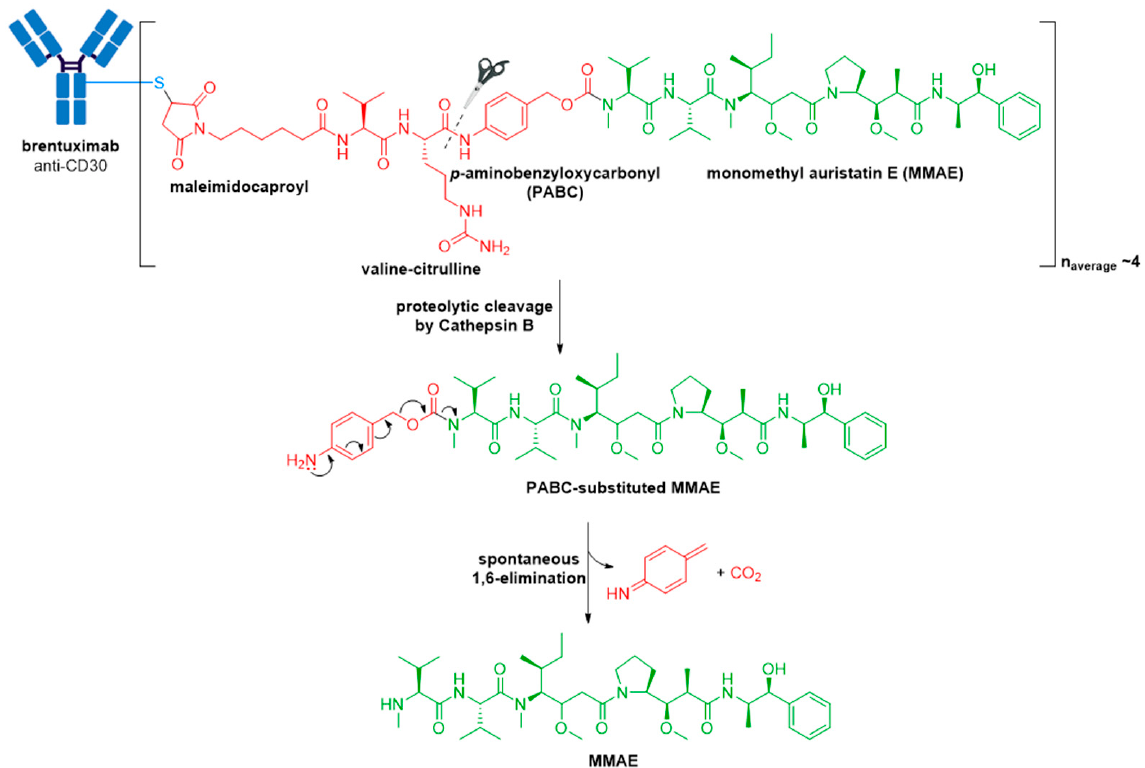
Figure 6. Structure of Adcetris ® (brentuximab vedotin). The antibody is shown in blue, and chemical structures for linker and payload are in red and green, respectively. Spontaneous 1,6-elimination mechanism for the PABC-substituted MMAE, leading to release of MMAE, p -iminoquinone methide, and carbon dioxide.